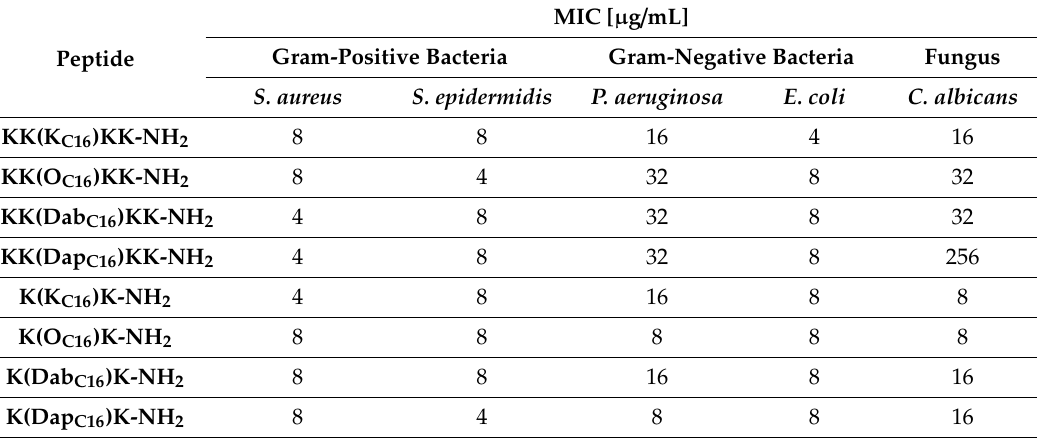
Table 1. Summary of minimum inhibitory concentrations of double-headed lipopeptides. Peptide